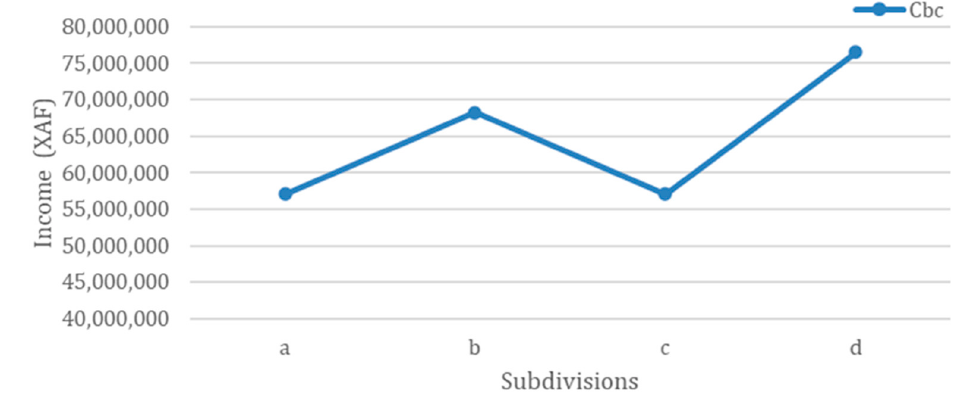
Figure 9. Change in incomes based on farm subdivisions in Figure 8.